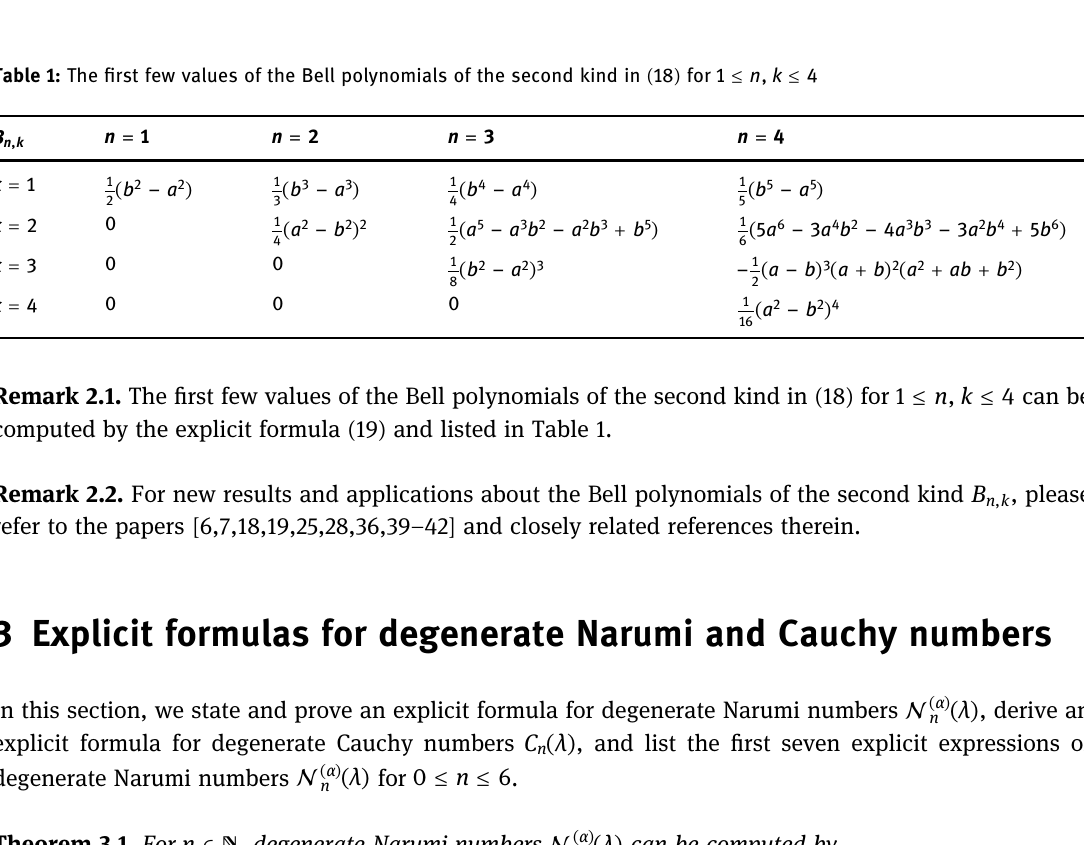
Table 1: The fi rst few values of the Bell polynomials of the second kind in ( 18 ) for ≤ ≤ n k 1 , B n k ,